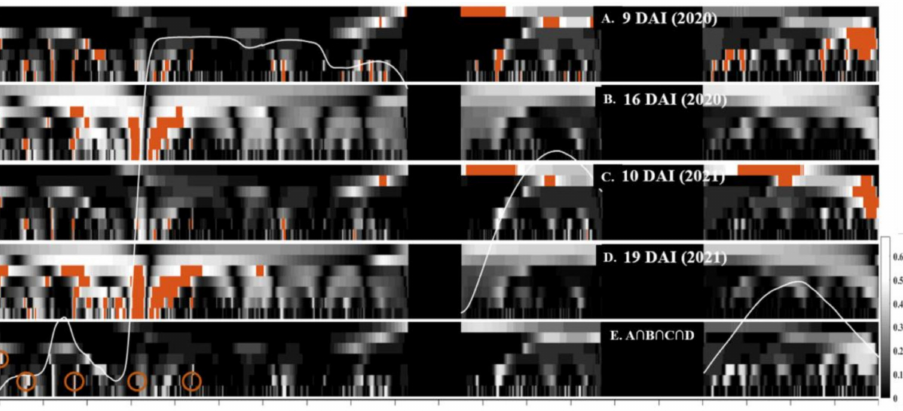
Figure 5. Correlation scalograms constituted from wavelet coefficients of canopy dataset (9 and 16 DAI) measured in 2019 ( A , B ) and 2020 ( C , D ). Finally, common features ( E ) from both years for spectral bands. The X -axis denotes spectral wavebands of range (400–2400 nm and Y -axis are the wavelet scales from 2 to 8. The grayscales’ higher brightness represents the high correlation with disease and vice versa. The orange color ( A – D ) highlights the top 5% most strong correlation, while ( E ) highlights intersected values (to interpret colored references in given figure legends, the reader is referred to consult the article’s web